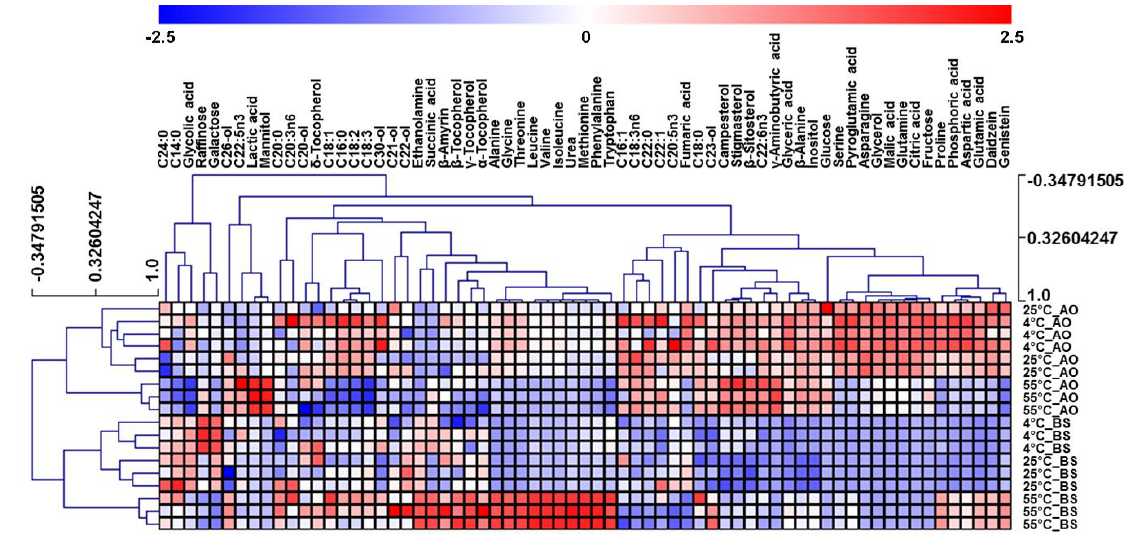
Figure 4. Heatmap representing differences in the relative metabolite concentrations of soybeans fermented by Aspergillus oryzae (AO) or Bacillus subtilis (BS). Increased and decreased contents of metabolites are shown by red and blue colors, respectively.